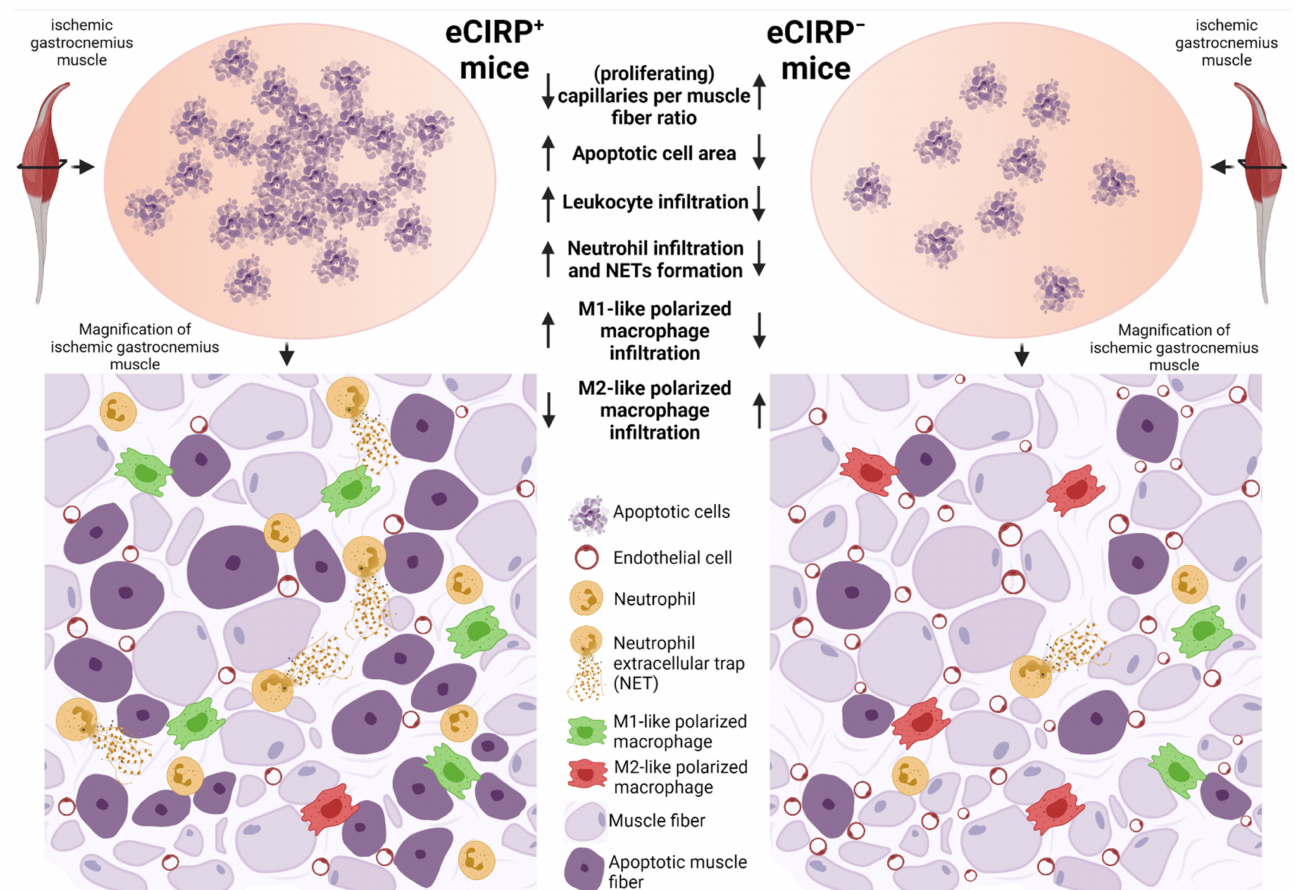
Figure 6. Depletion of extracellular “Cold-inducible RNA-binding protein” (eCIRP) promotes ischemia-induced angio- genesis and affects the associated leukocyte infiltration. In comparison to control mice, which still harbor eCIRP, mice with neutralized eCIRP showed an increased (proliferating) capillaries per muscle fiber ratio, reduced areas of apoptotic cells, reduced leukocyte infiltration with lower numbers of neutrophils, neutrophils that produce neutrophil extracellular traps (NETs), and pro-inflammatory M1-like polarized macrophages, whereas the number of infiltrative anti-inflammatory regenerative M2-like polarized macrophages was elevated. Thus, eCIRP-depleted mice show an ameliorated angiogenic capacity upon ischemia, mediated through a more pro-angiogenic inflammatory